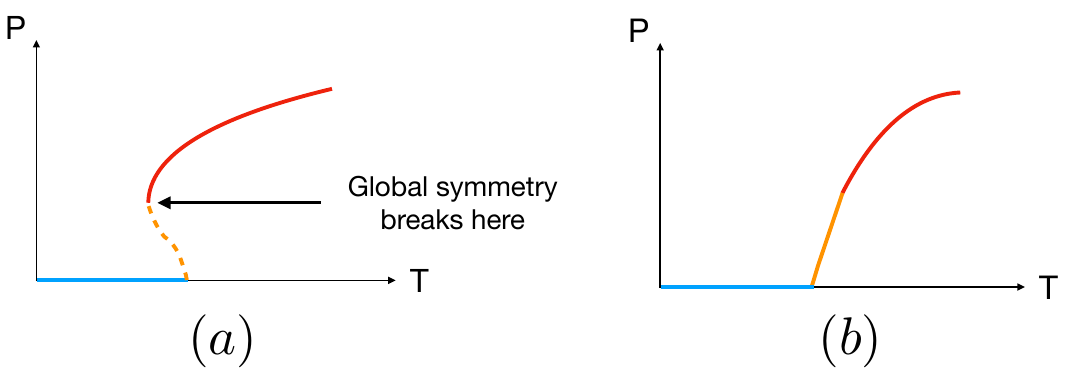
Figure 2. Schematic depiction of the Polyakov loop expectation value, P , as a function of temperature T for a confinement/deconfinement transition that is (a) first order or (b) second order or higher, i.e. continuous. The blue, orange and red curves represent the confined, partial, and deconfined phases, respectively. The theories we study in this paper have first-order transitions, as in (a). We find that the global symmetry that is spontaneously broken in the confined phase, namely CP or chiral symmetry, is also broken in the partial phase. As a result, the transition from the deconfined to partial phases is characterised by the spontaneous breaking of this global symmetry, as indicated in